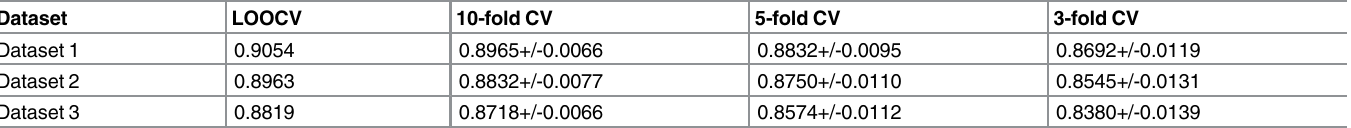
Table 2. Performance of NLLSS under the validation framework of LOOCV, 10-fold CV, 5-fold CV, and 3-fold CV, which have demonstrated the NLLSS has a reliable and robust performance. Dataset